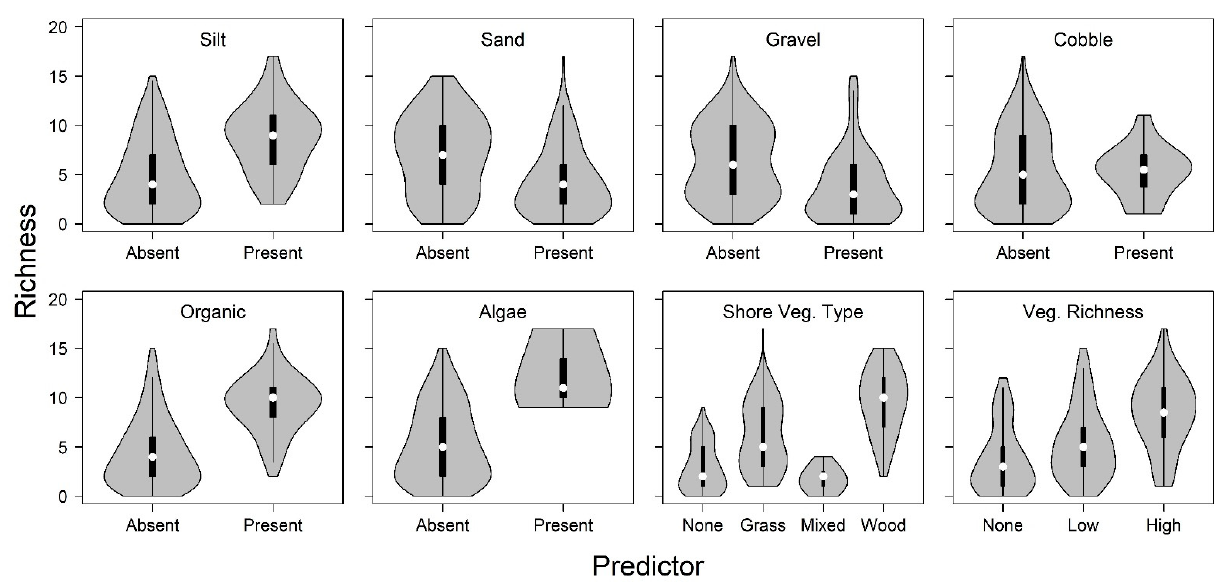
Figure 3. Model-averaged slope parameter estimates for predictor variables from 256 candidate generalized linear mixed models. ‘Grass’, ‘Mixed’, and ‘Wood’ refer to shoreline vegetation types, whereas ‘VR-L’ and ‘VR-H’ refer to low and high aquatic macrophyte richness, respectively. Error bars represent 95% confidence intervals calculated based on uncondi- tional standard errors.